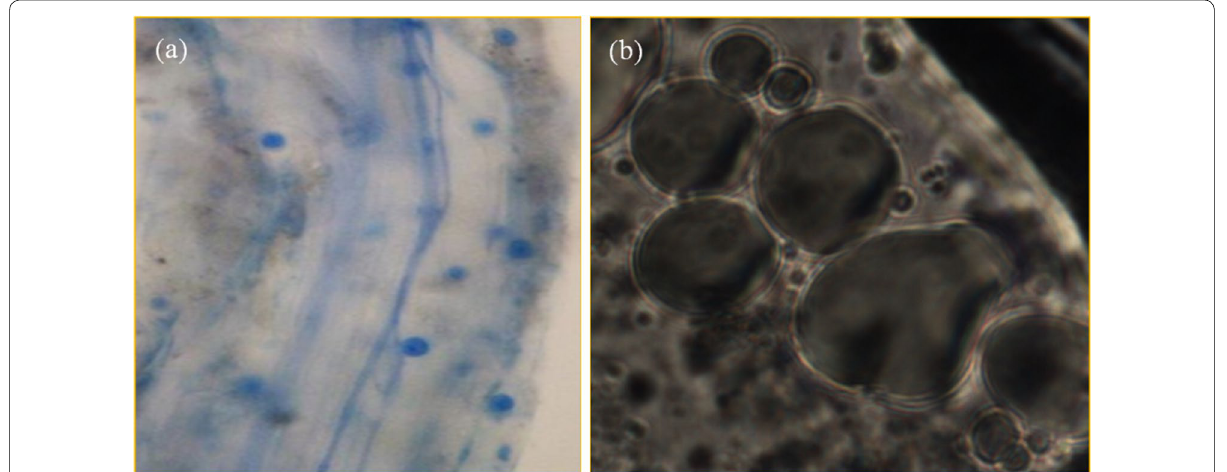
Fig. 2 Hyphae, chlamydospores ( a ) and spores ( b ) produced by S. indica in roots cortex of L. multiflorum